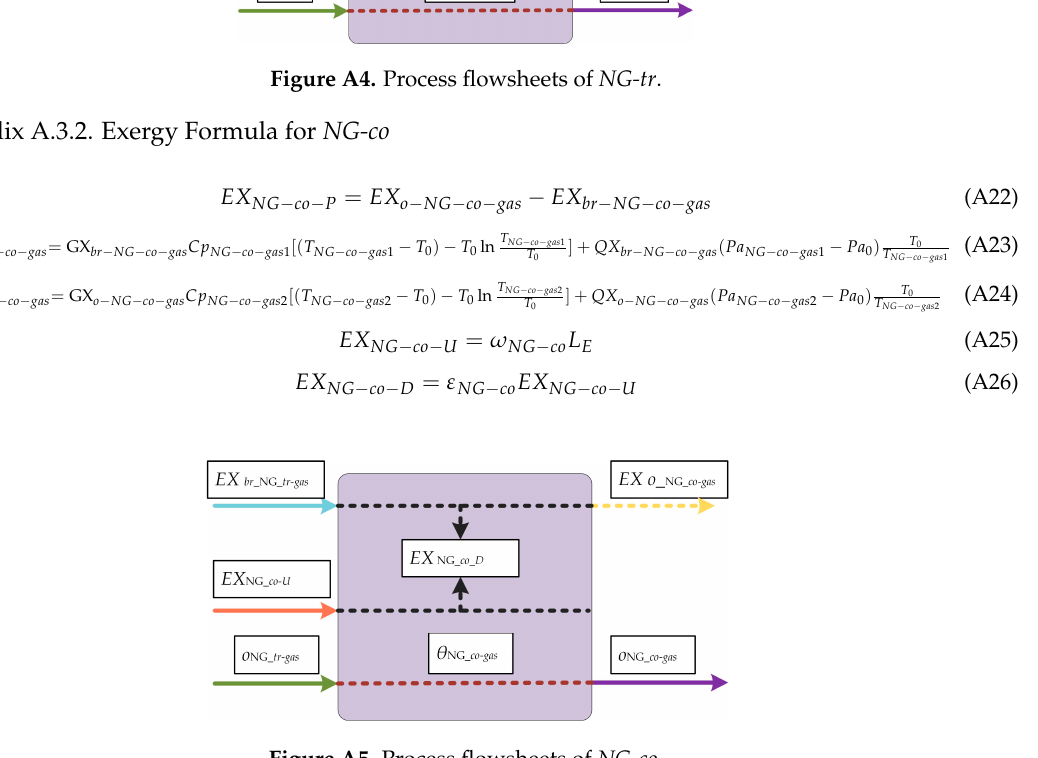
Figure A5. Process flowsheets of NG-co .